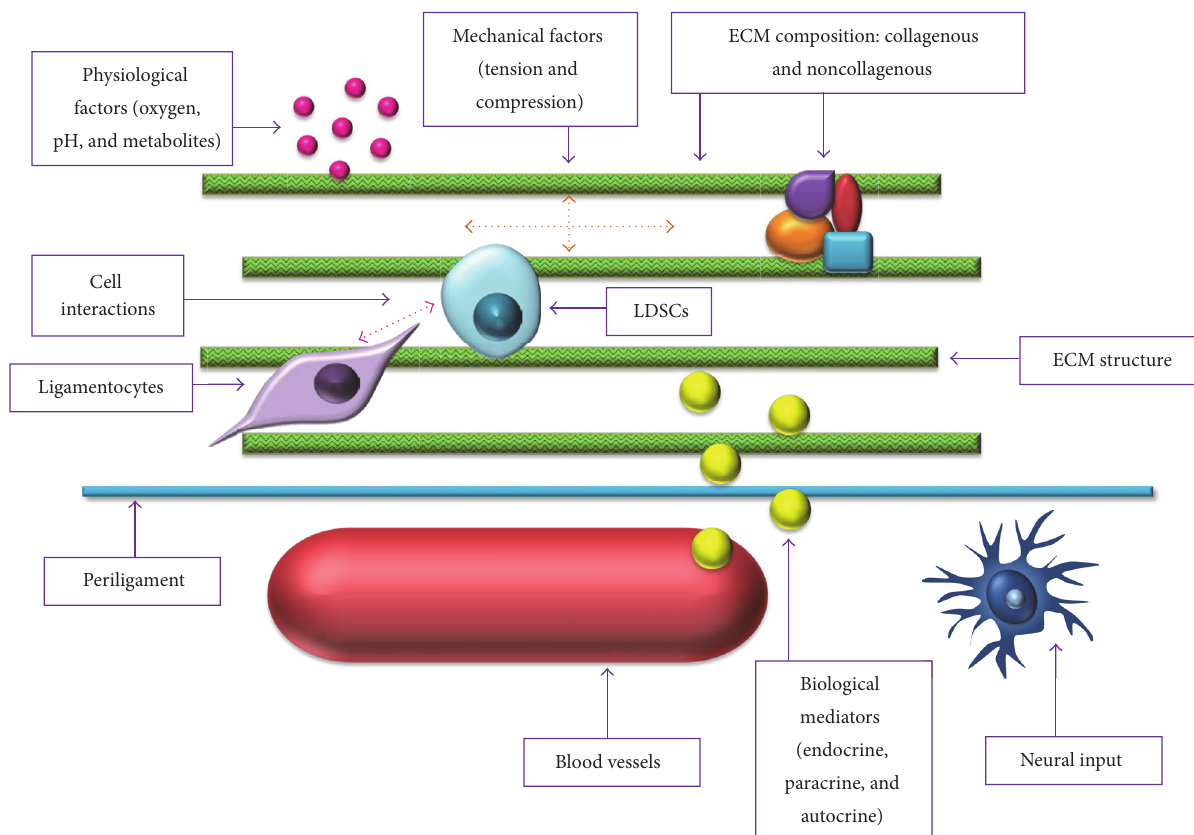
Figure 3: The potential factors comprising the ligament stem cell